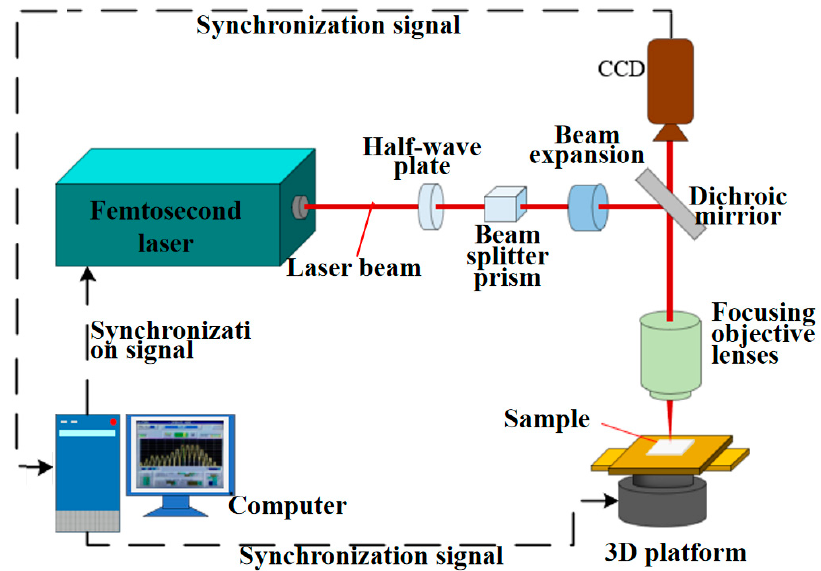
Figure 2. Experimental system of femtosecond laser direct writing processing.